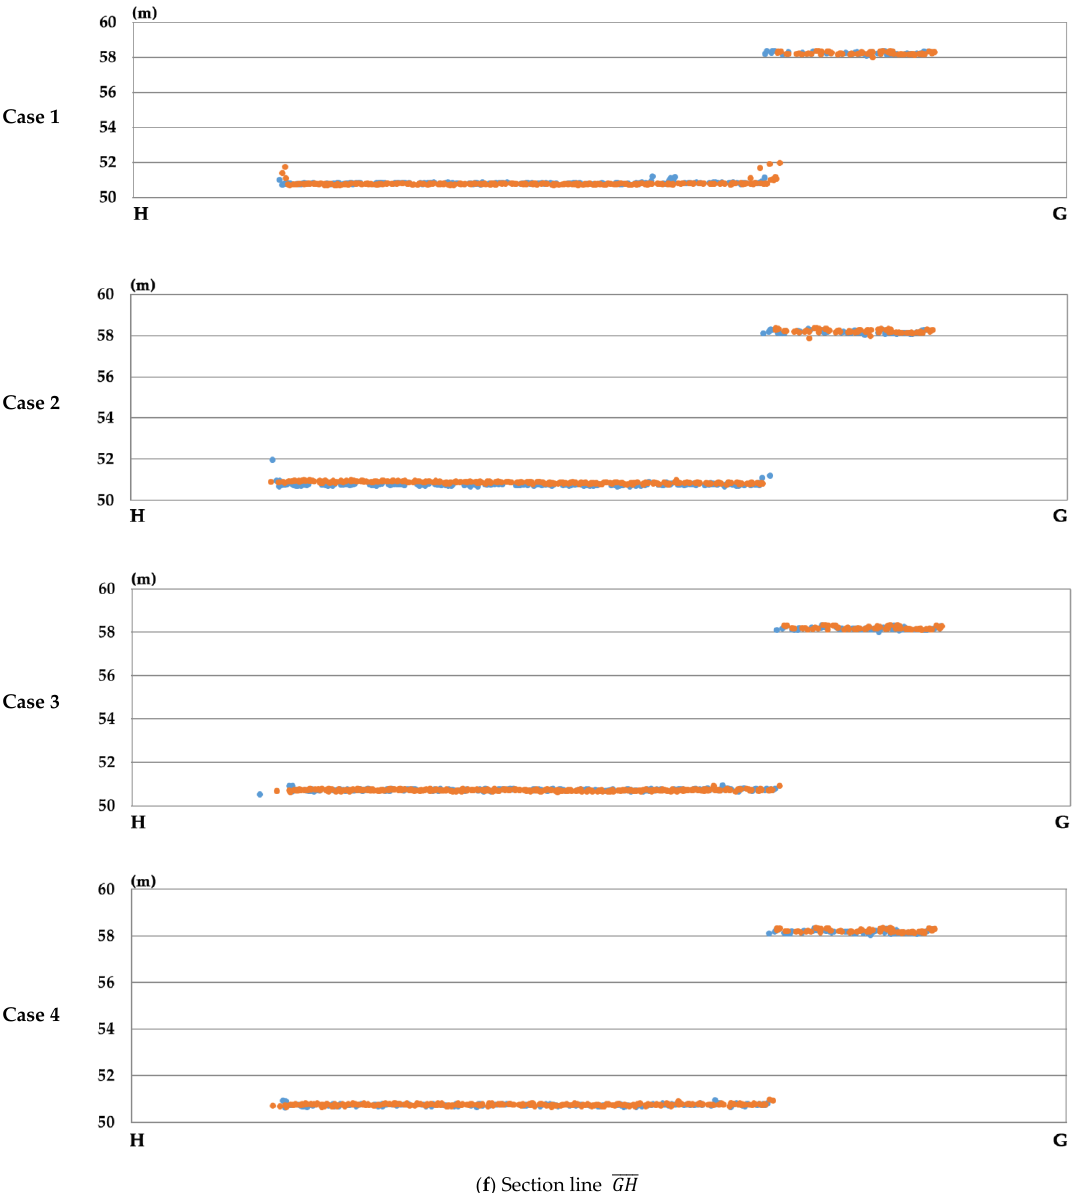
Figure 5. Between the strips in section lines GH , KL , PQ , RS , TU , and VW in Cases 1, 2, 3, and 4. Different colors represent different strips. A scale of abscissa axis is 1:280.